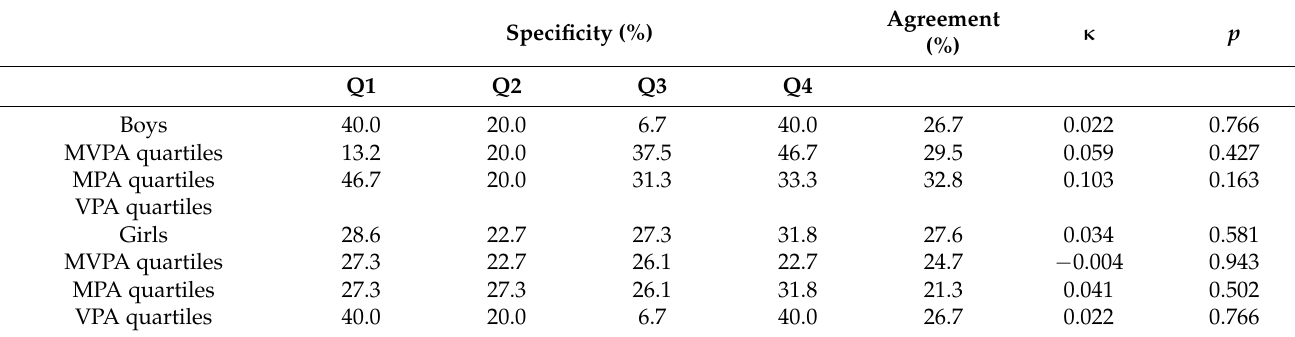
Table 4. Agreement between the questionnaire-based and SWA-based categorization of female and male adolescents into the quartiles according to the time spent at different intensities of PA determined using percent agreement and Kappa statistics. Specificity (%)